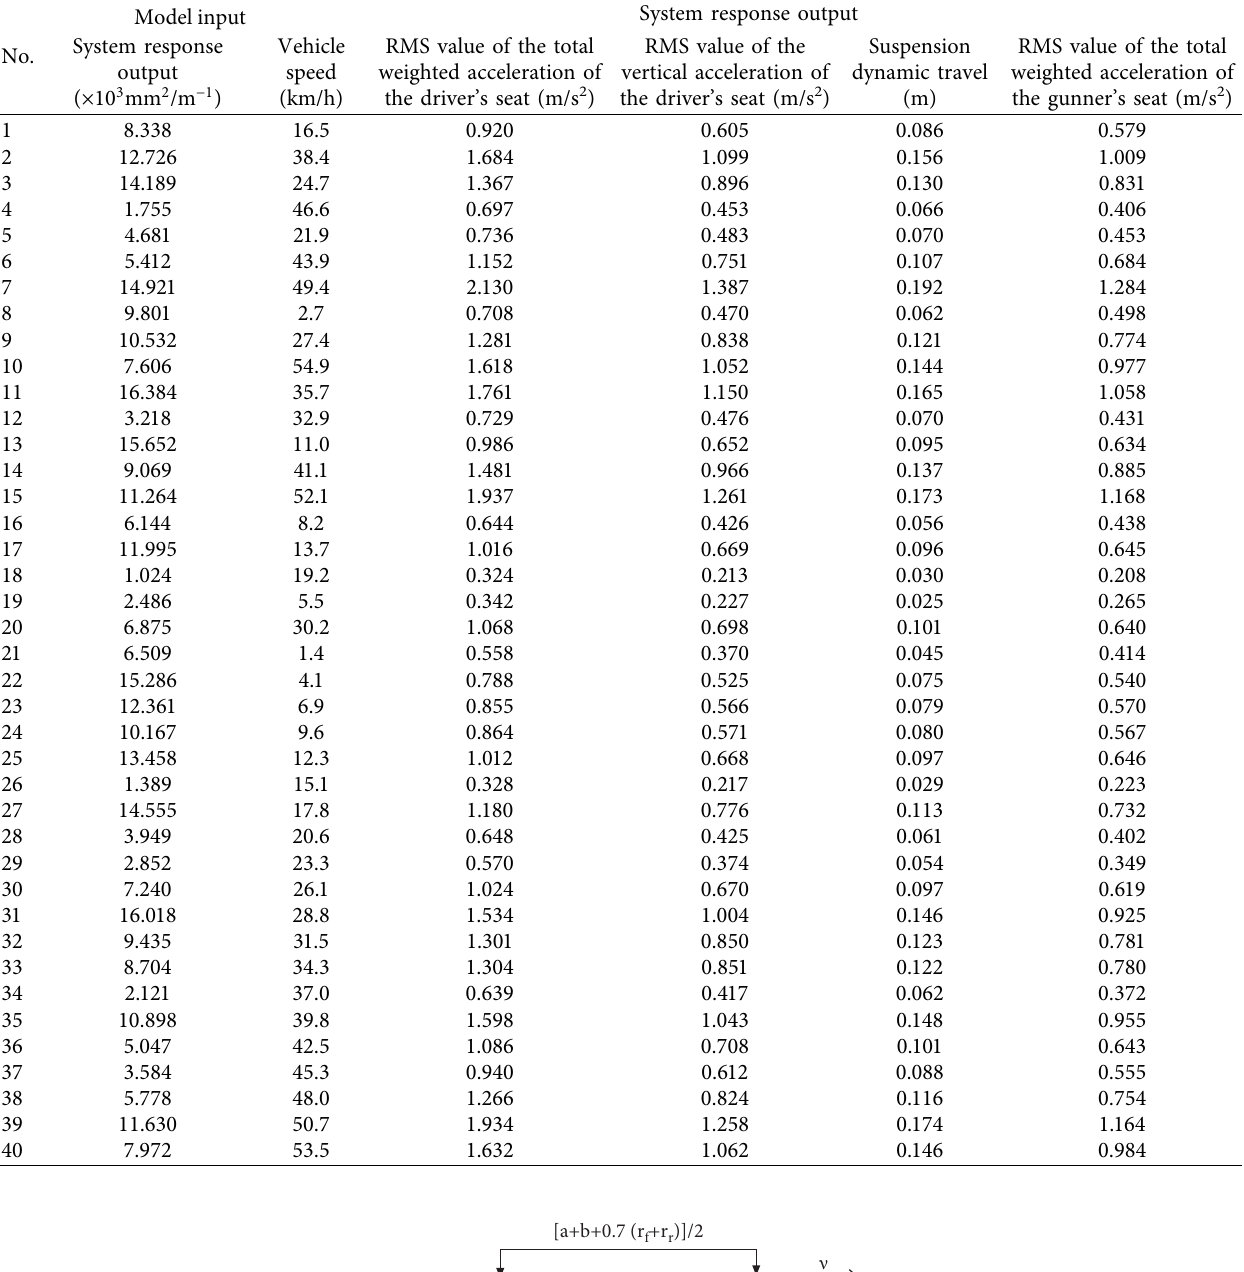
Table 6: Simulation results of vibration response evaluation index.